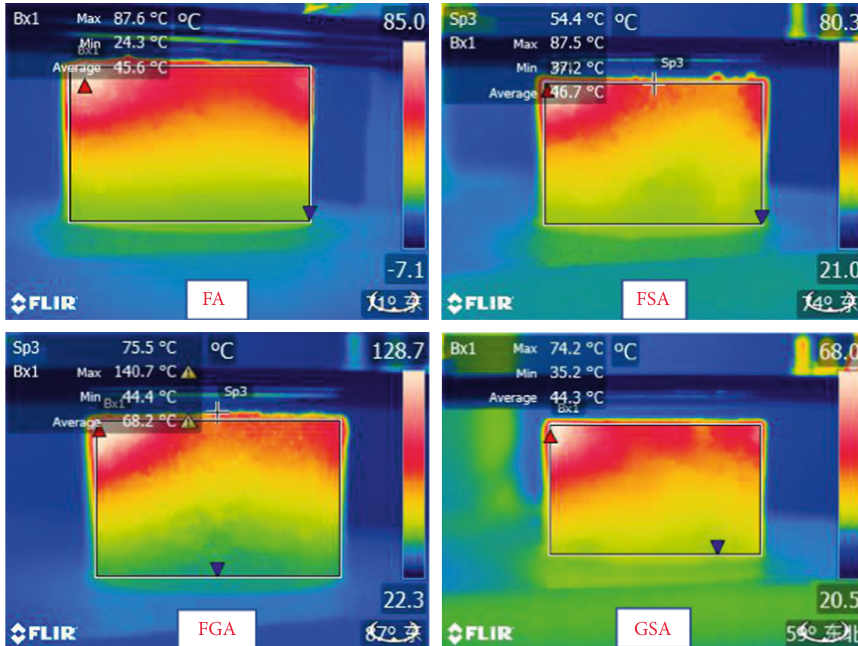
Figure 11: Induction heating infrared images of different asphalt concretes after 120s.